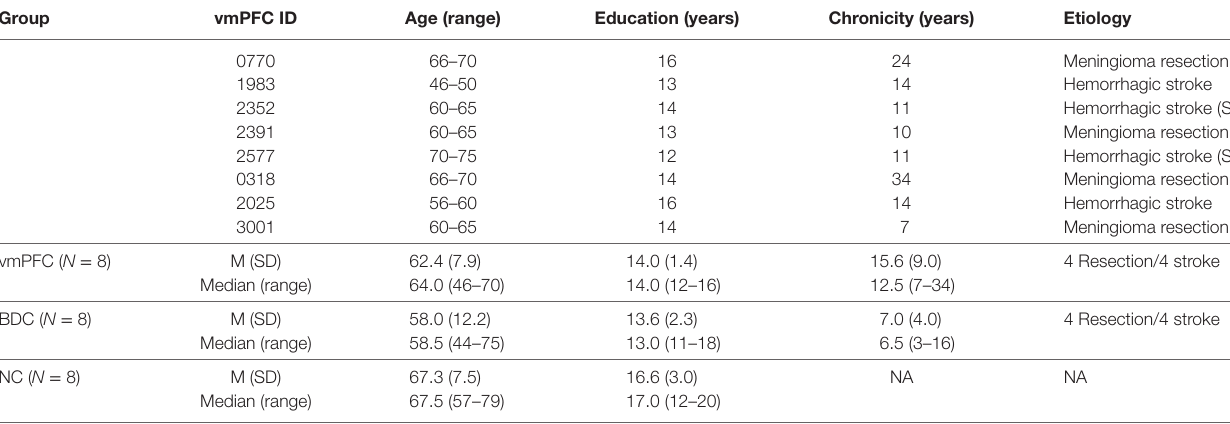
TaBle 1 | Demographic characteristics of